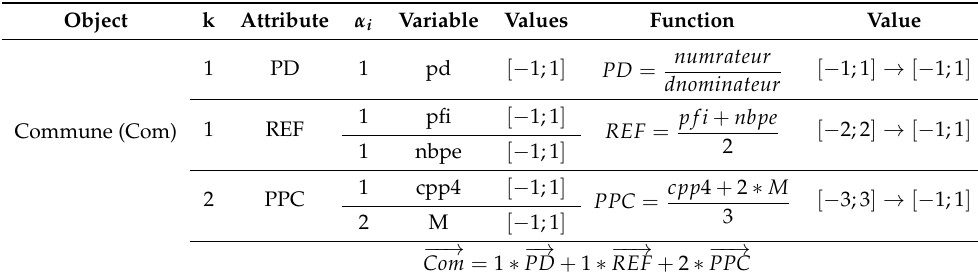
Table 4. Setting of the object “Municipality”.